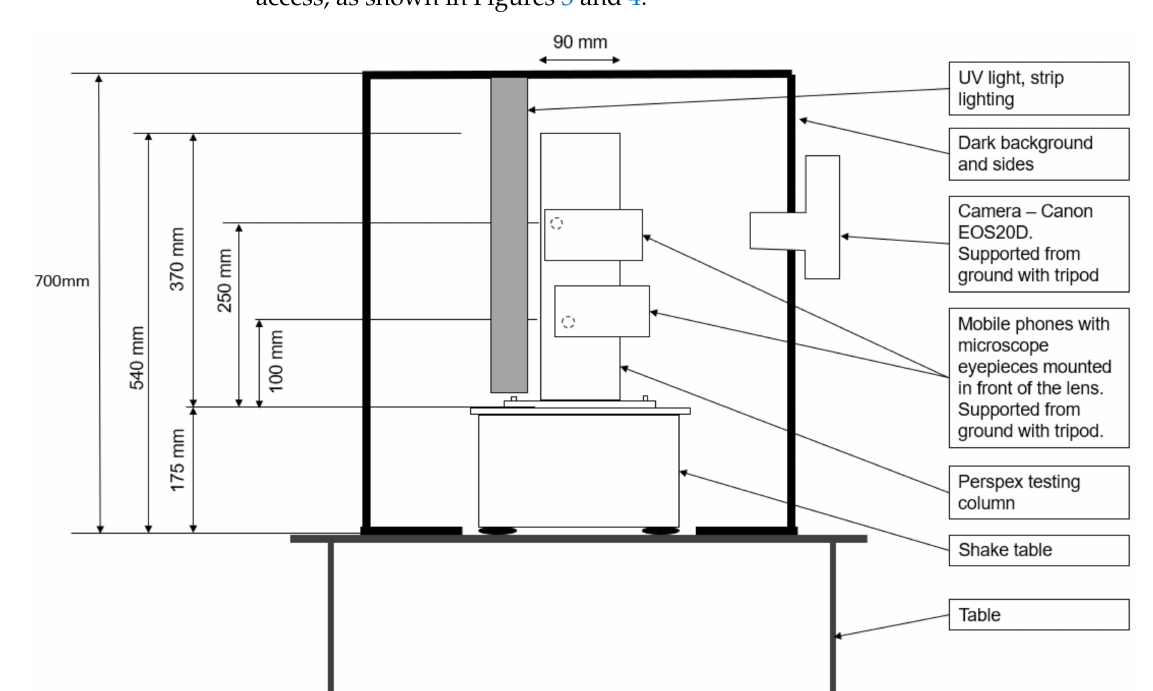
Figure 3. Experiment 2 setup—front elevation.